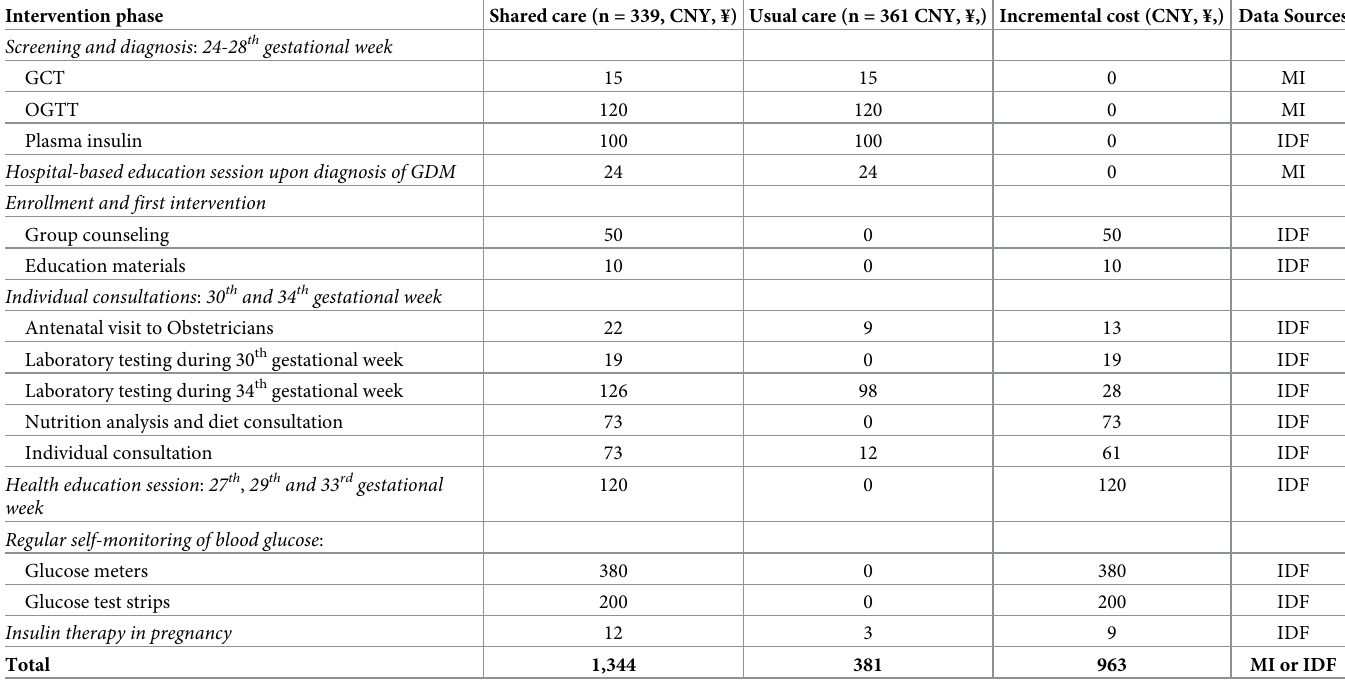
Table 1. Intervention costs of a lifestyle intervention program for women with gestational diabetes in China, per study participant, by study arm. Intervention phase